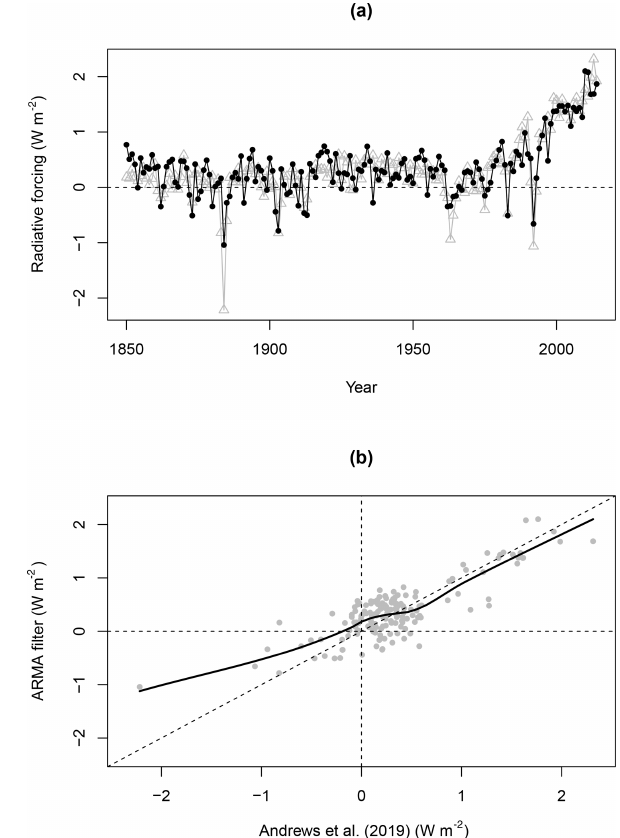
Figure 3. Comparison of forcing series estimated from HadGEM3- GC3.1-LL simulations of the historical period. In panel (a) grey triangles denote forcings estimated by Andrews et al. (2019), while black dots denote forcings obtained using the three-box ARMA fil- ter. Panel (b) shows how estimates from the two methods vary over the range of forcing values using a non-parametric curve fit. The diagonal line has equation y = x